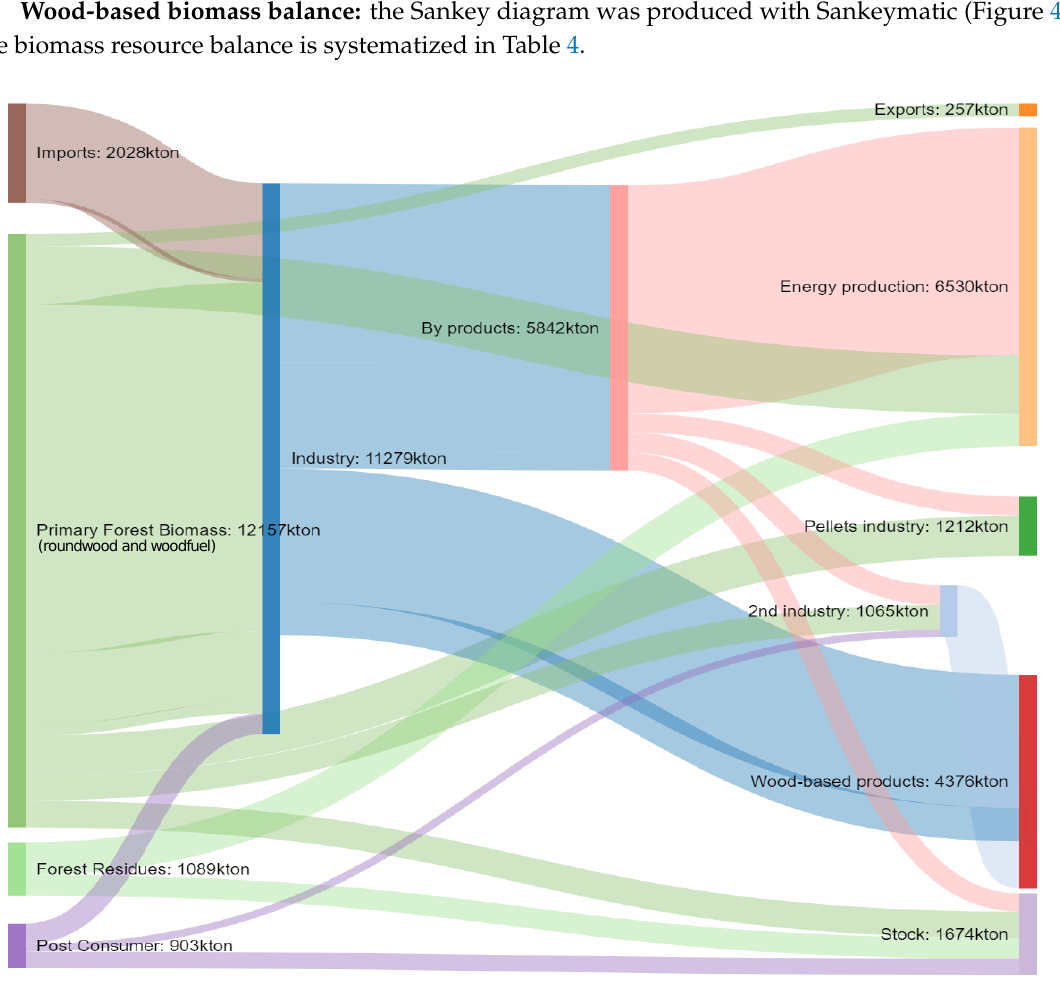
Figure 4. Sankey diagram of the wood-based biomass flows in Portugal, 2016.